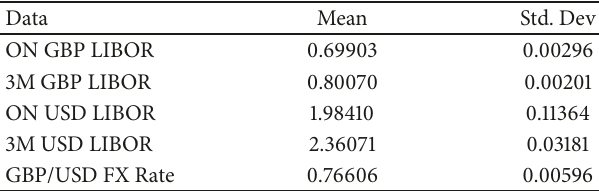
Figure 4: Visual Plot of the Simulated USD 3M LIBOR. Table 1: Descriptive Statistics of the Data.